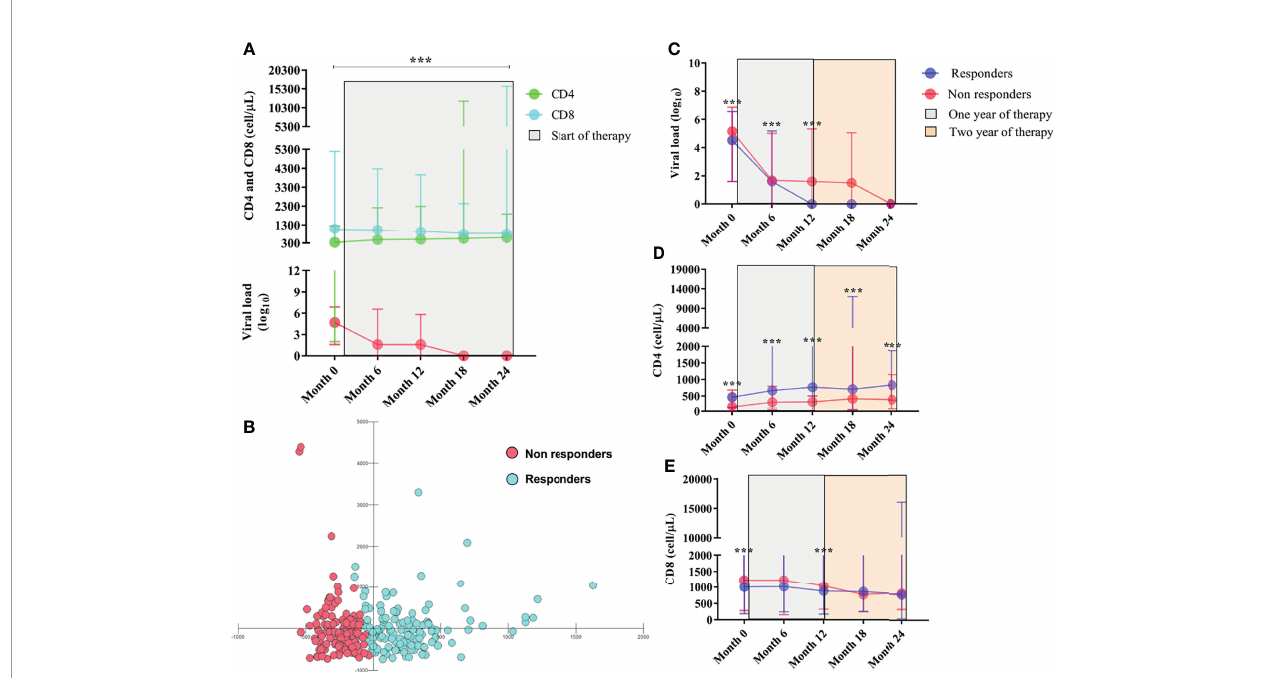
FIGURE 1 | (A) Longitudinal immunovirological evaluation of PLHIVs before and throughout ART during the two-year treatment period. Viral load is in red. (B) Scatter plot of multivariate discriminant analysis of viral load and CD4+ T and CD8+ T lymphocyte counts showing the groups of therapeutic responders and nonresponders categorized based on CD4+ T lymphocyte count ≥ or < 500 cells/µL. (C) Longitudinal evaluation of viral load. (D) CD4+ T lymphocyte count and (E) CD8+ T lymphocyte count between responders and nonresponders before and after the start of therapy. ***: p <